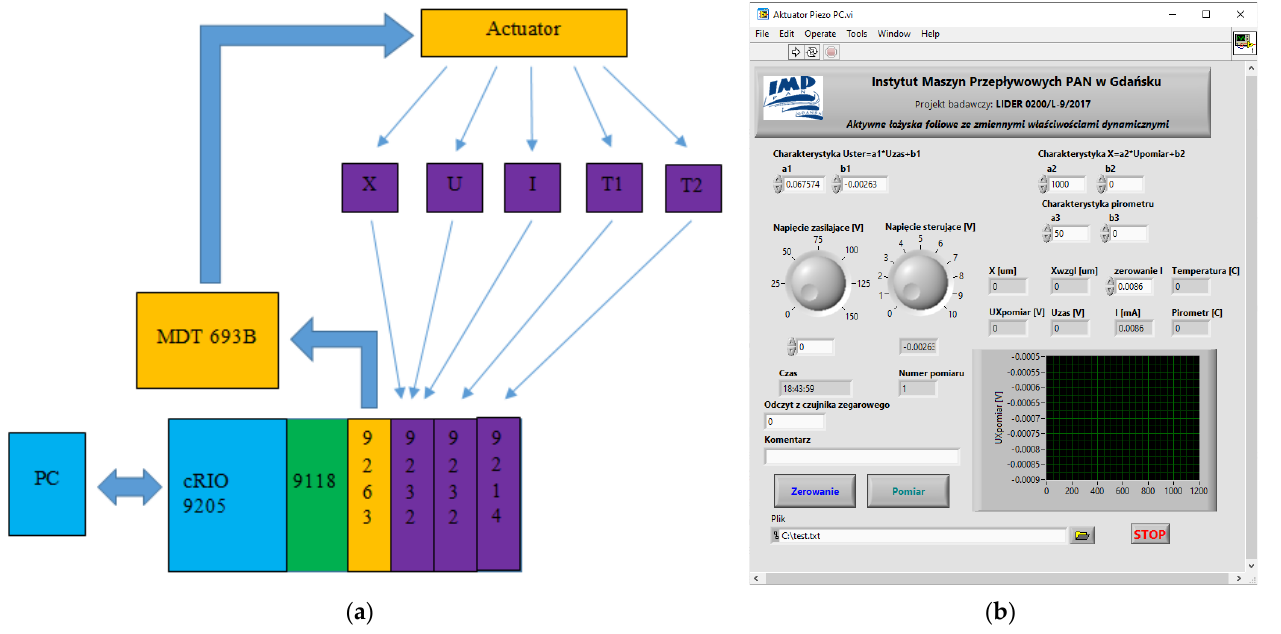
Figure 3. The measurement system used for the testing of piezoelectric actuators: ( a ) block diagram showing the hardware configuration; ( b ) the graphical user interface of the control application.